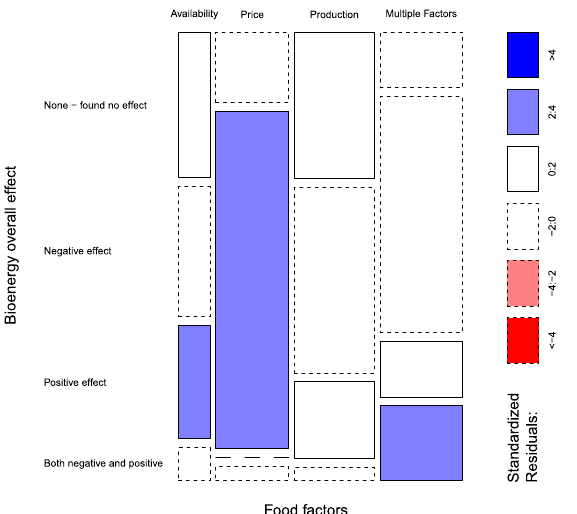
Fig. 3 Mosaic plot of standardized residuals for the food security parameters by the overall effect. Cells that are shaded light blue indicate there are three standardized residuals that are between two and four which is larger than would be expected if there was no relationship between food security parameters and overall effect. Cells with solid borders indicate positive residuals, whereas cells with dashed borders indicate negative